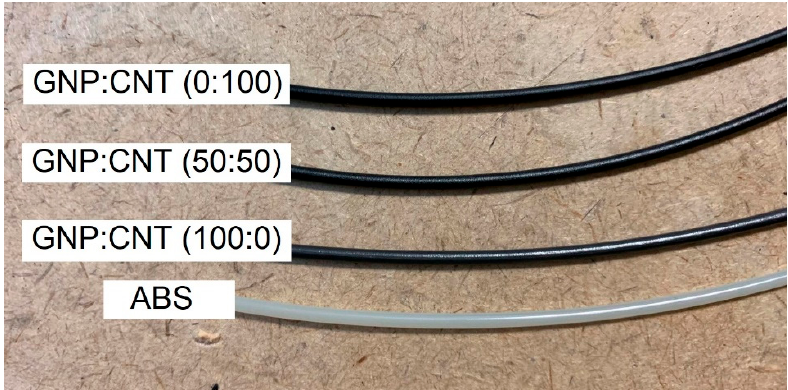
Figure 1. Filaments of neat acrylonitrile butadiene styrene (ABS), and graphene nanoplatelet (GNP)/multi-walled carbon nanotube (CNT) (100:0), GNP/CNT (50:50), and GNP/CNT (0:100) nanocomposites at 6 wt.% of nanofiller.